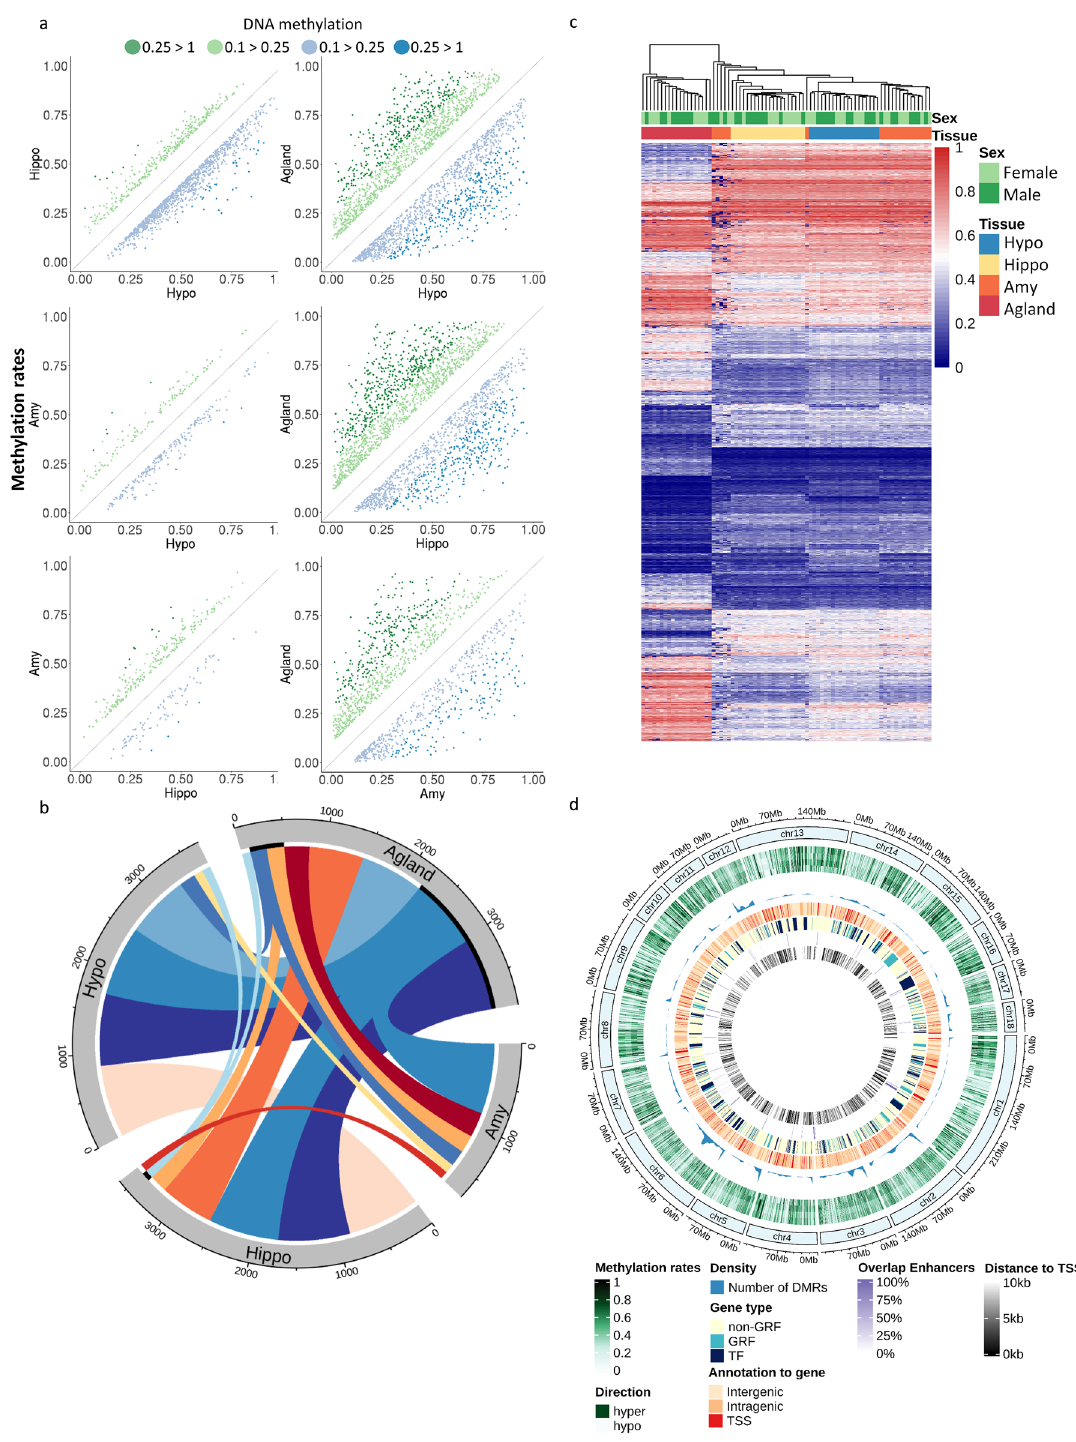
Figure 3. DMRs across Hypo, Hippo, Amy, and Agland. ( a ) Scatter plots of DMR methylation pairwise comparisons (> 10 meCpGs, mean methylation rate > 0.1, and q-value < 0.05). Green and blue indicate an increase or decrease in methylation compared across tissues, respectively (> = 0.1, light, > = 0.25, dark). ( b ) Circos plot 63 displaying 85% (4959/5787) of the total overlapping DMRs detected across pairwise tissue comparisons (Supplementary Table S9). Thick inner black line indicate overlaps of non-unique to pair DMRs. Only overlaps greater than 95 are shown. ( c ) Hierarchical clustering of samples based on DMR’s mean methylation rates per sample. ( d ) Circos plot 63 displaying DMR’s methylation rates and annotation across chromosomes. From outside to inside of the plot: mean methylation rates for Hypo, Hippo, Amy, and Agland (green, hypomethylated: light, hypermethylated: dark), the genomic density of regions (fraction of DMRs per chromosome), annotation to gene, type of gene (TF, GRF, other), annotation to enhancers in pigs 13 , and distance to